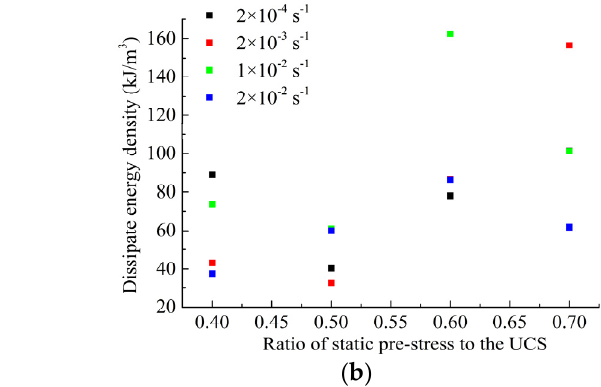
density and dissipated energy density. When the static pre-stress is 40% of the UCS, the